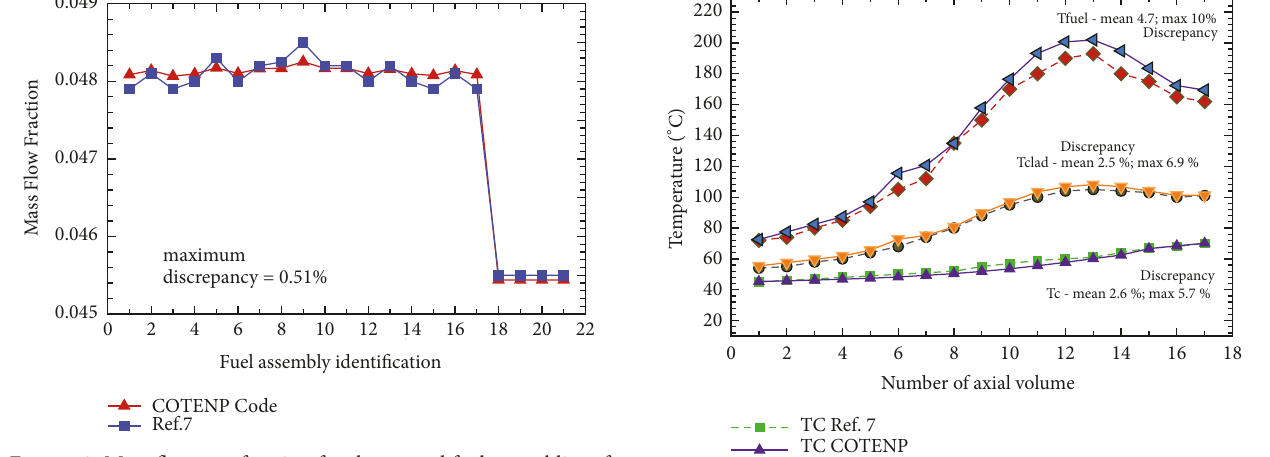
Figure 8: Mass flow rate fraction for the several fuel assemblies of the CARR reactor.Comparison between the COTENPcode and [7].